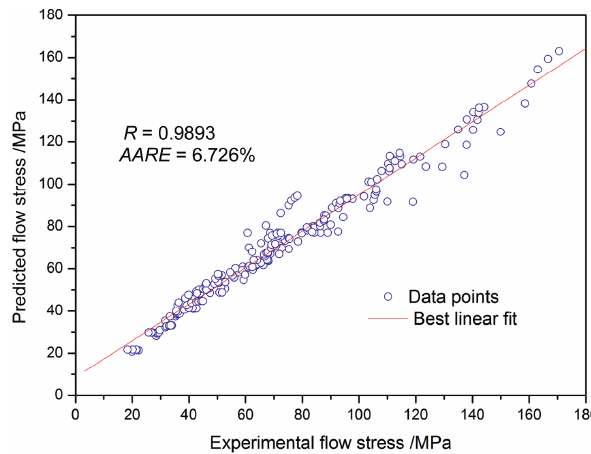
Figure 11: Correlation between the experimental and predicted flow stress data from the developed constitutive